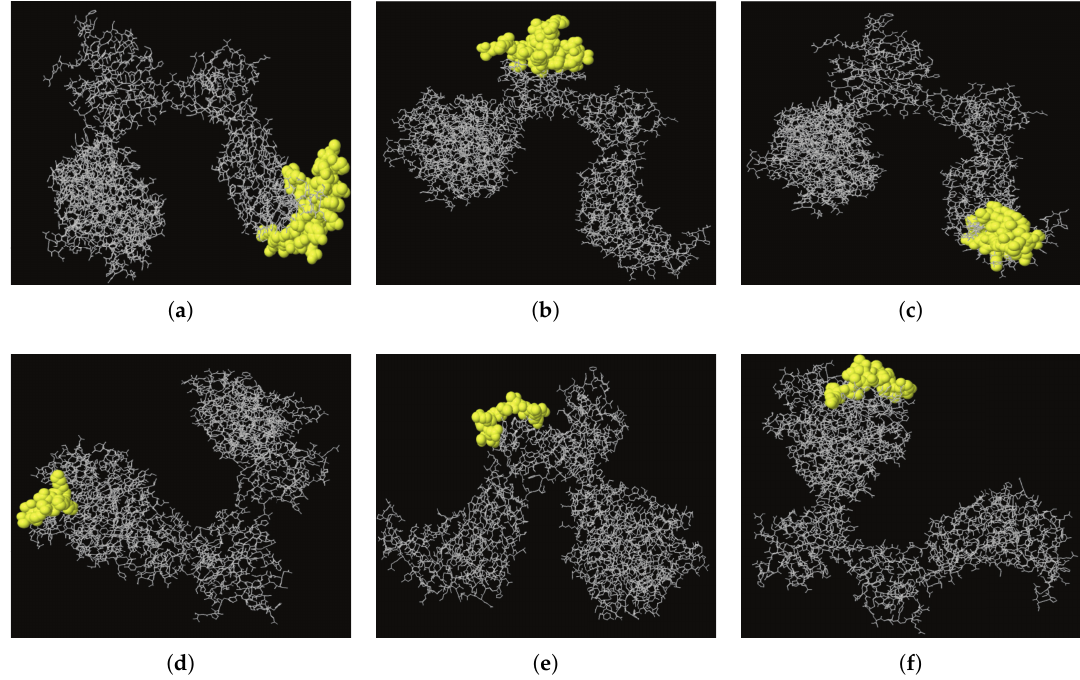
Figure 3. Three-dimensional locations of discontinuous epitopes ( a – f ) predicted in the MERS-CoV spike protein. The epitopes are shown in yellow, with the bulk of the MERS-CoV spike protein as grey